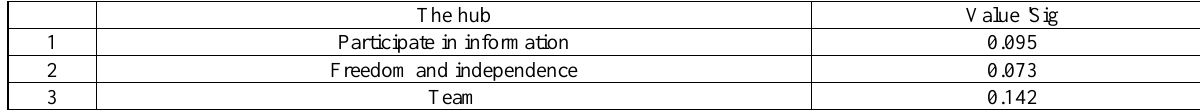
Table 10. Natural Distribution Test for Human Resources Enabling Axes